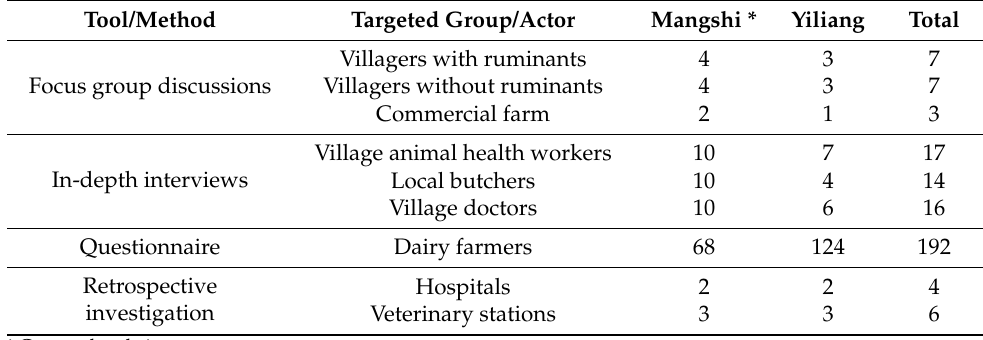
Table 1. Summary of data collection done in two counties in Yunnan Province,